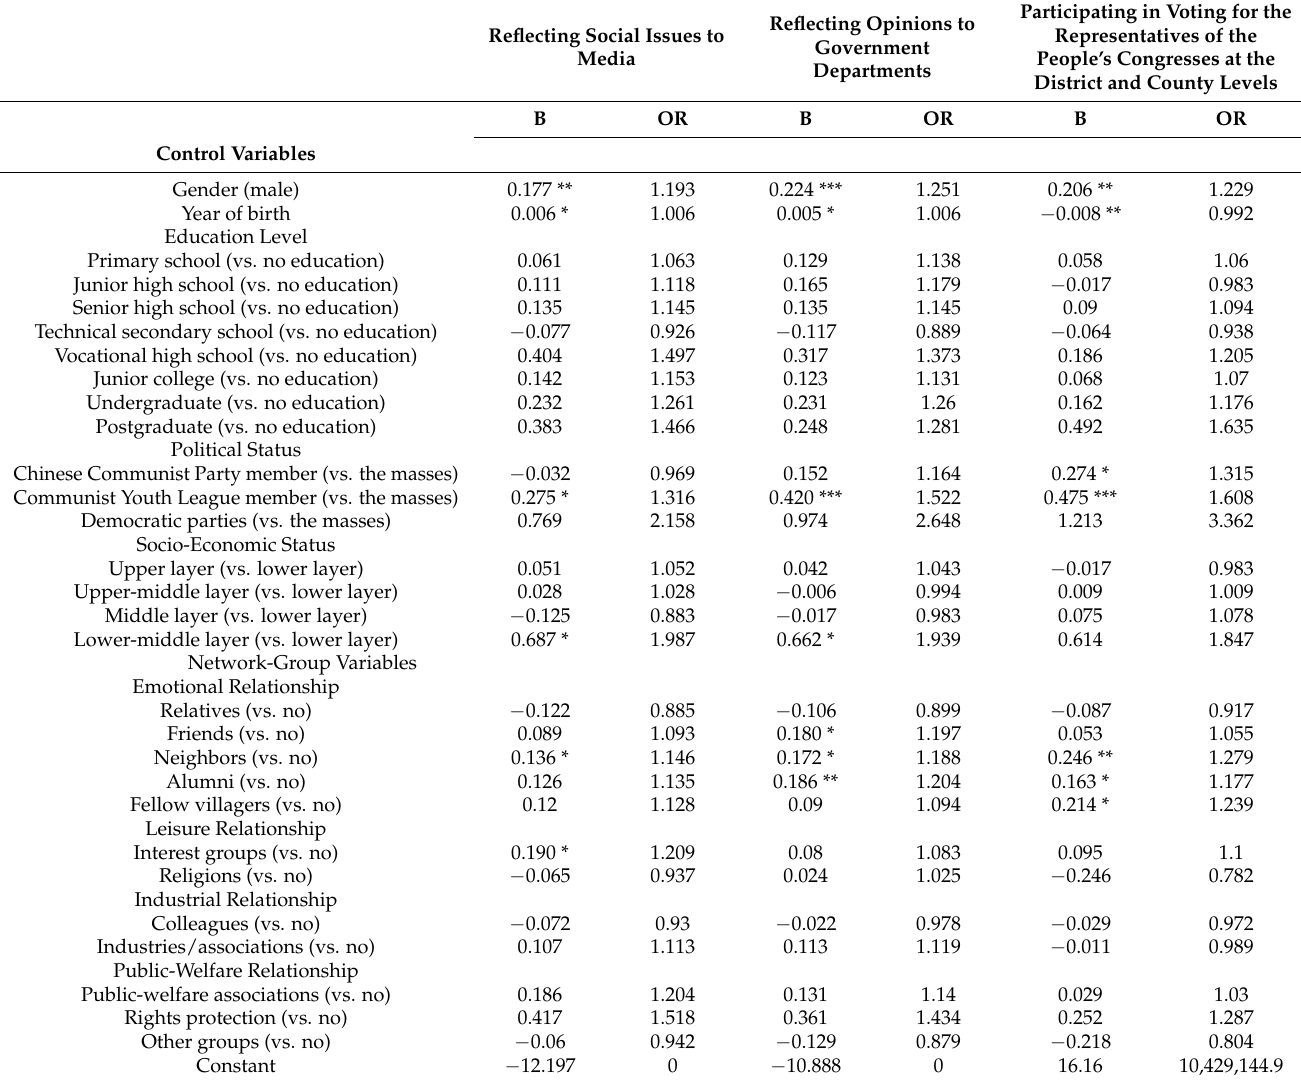
Table 2. Results of hierarchical logistic regression of indirect political